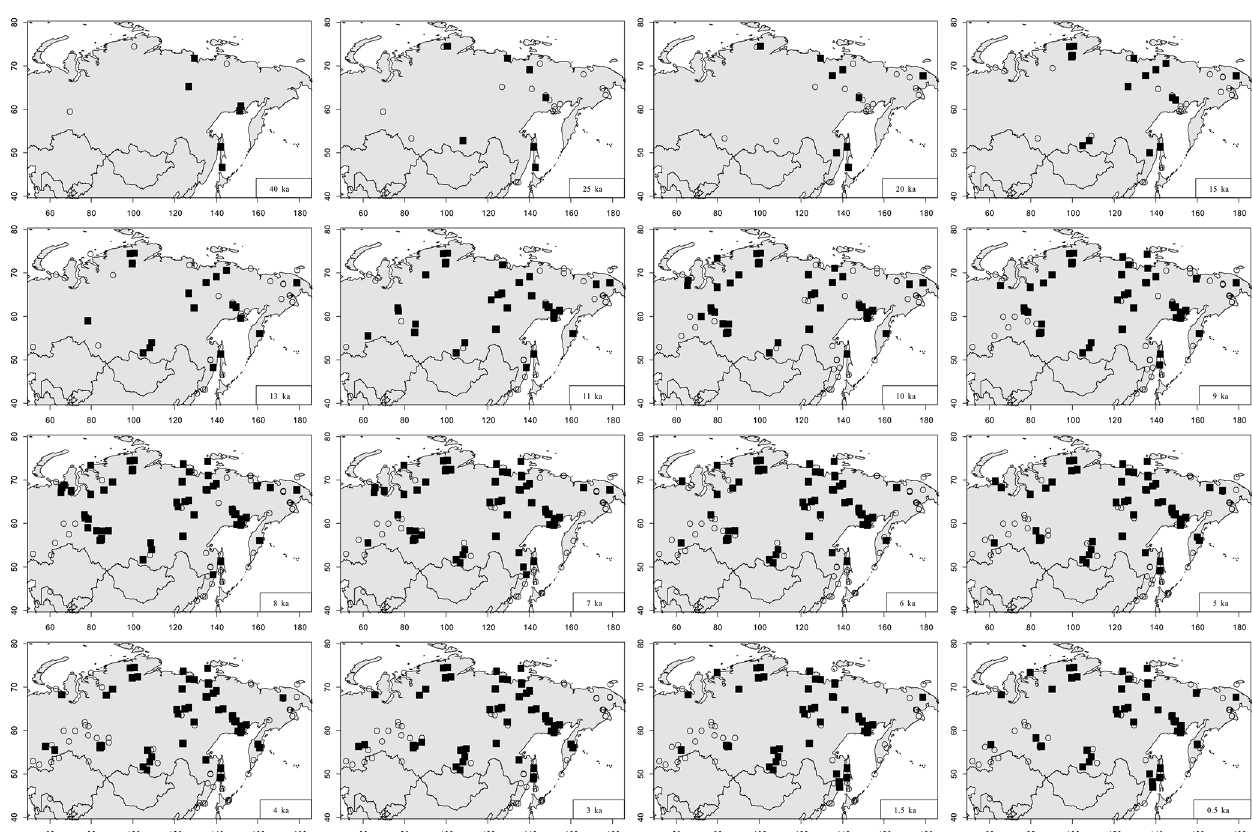
Figure 2. Pollen-inferred presence–absence maps for Larix at key time slices. Black squares indicate presence while empty circles indicate